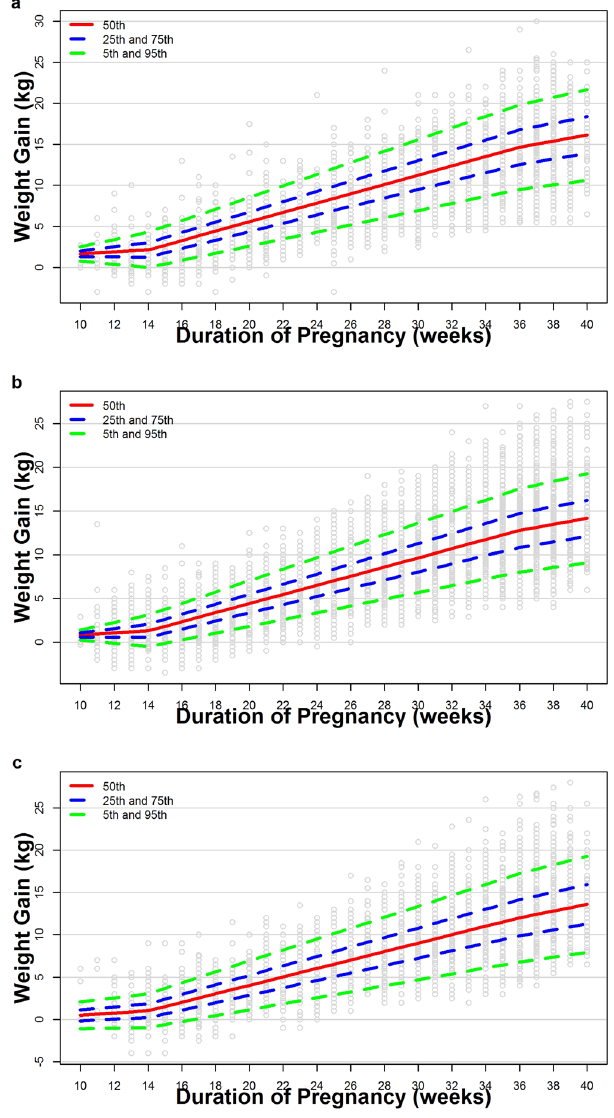
Figure 3. ( a – c ) Estimated trajectories at 5th, 25th, 50th, 75th, and 95th centiles of weight over gestational weeks among underweight ( a ), normal weight ( b ), and overweight ( c ) women. Small grey circles are actual observations.